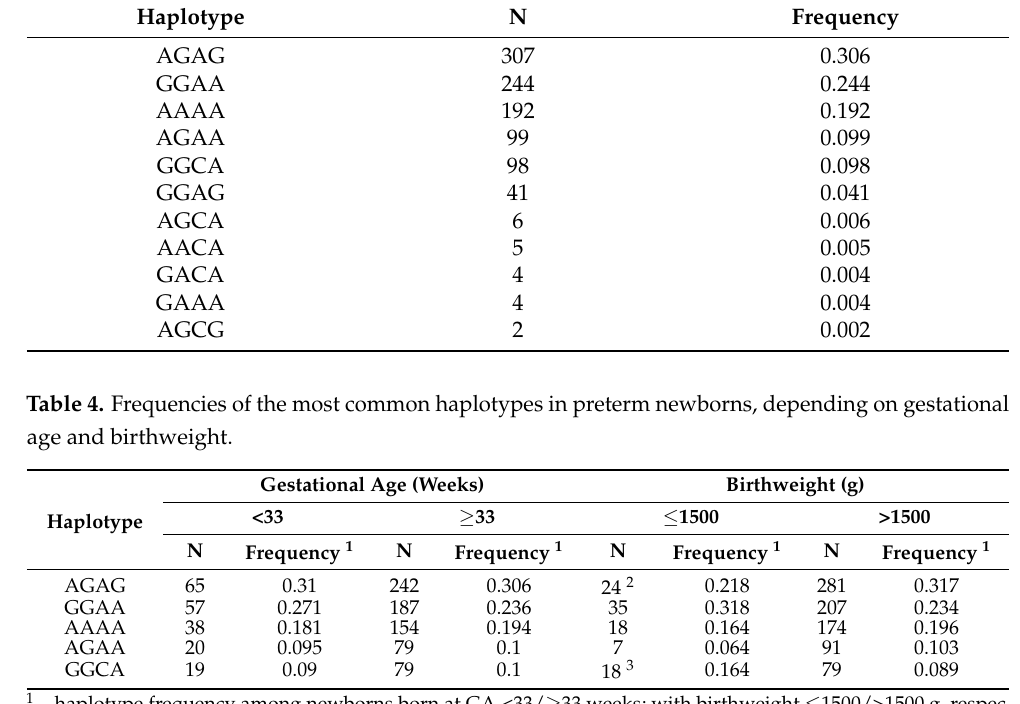
Table 3. Frequencies of haplotypes identified in preterm newborns (n = 501). Haplotype N